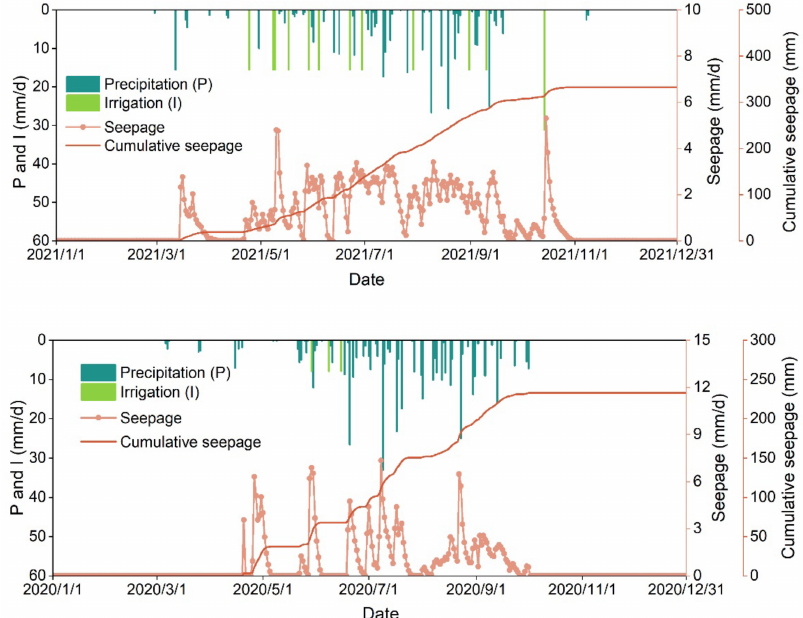
Figure 6. Variations of seepage and cumulative seepage in turf growth period with precipitation and irrigation conditions in 2020 and